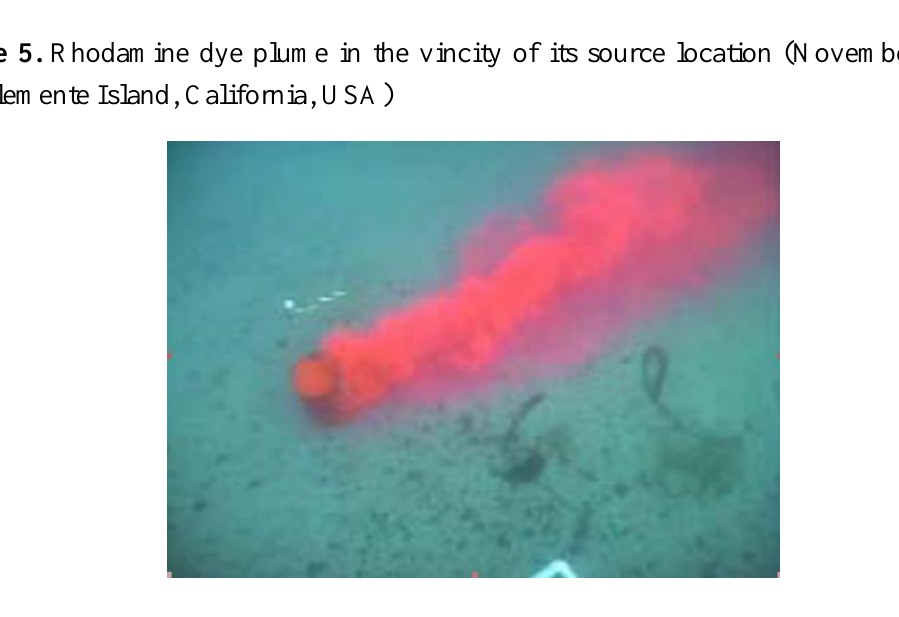
Figure 6. The AUV for the field experiments conducted in October 2010, developed by the Shenyang Institute of Automation, Chinese Academy of Sciences.